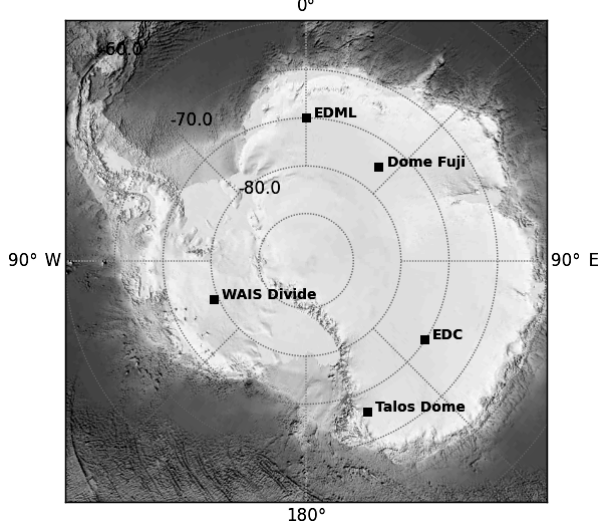
Figure 1. Drilling locations of the ice cores where the CO 2 and isotopic paleotemperature records included in this study were mea- sured.